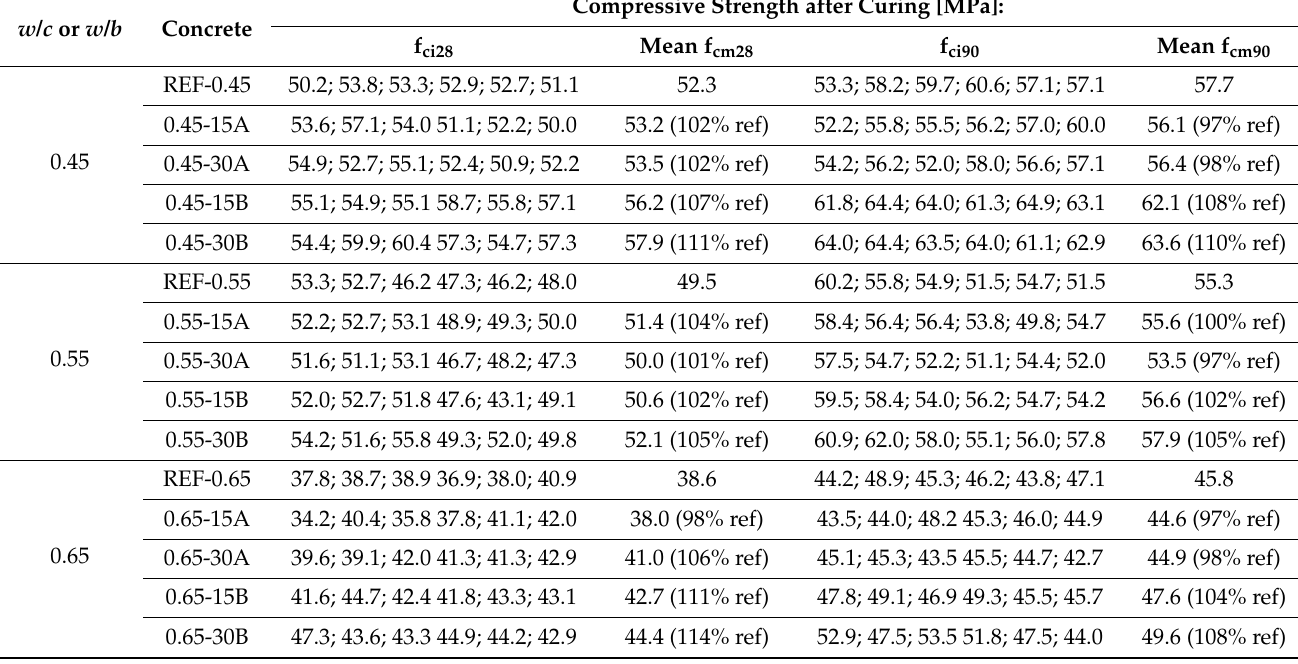
Table 8. Results of compressive strength testing of